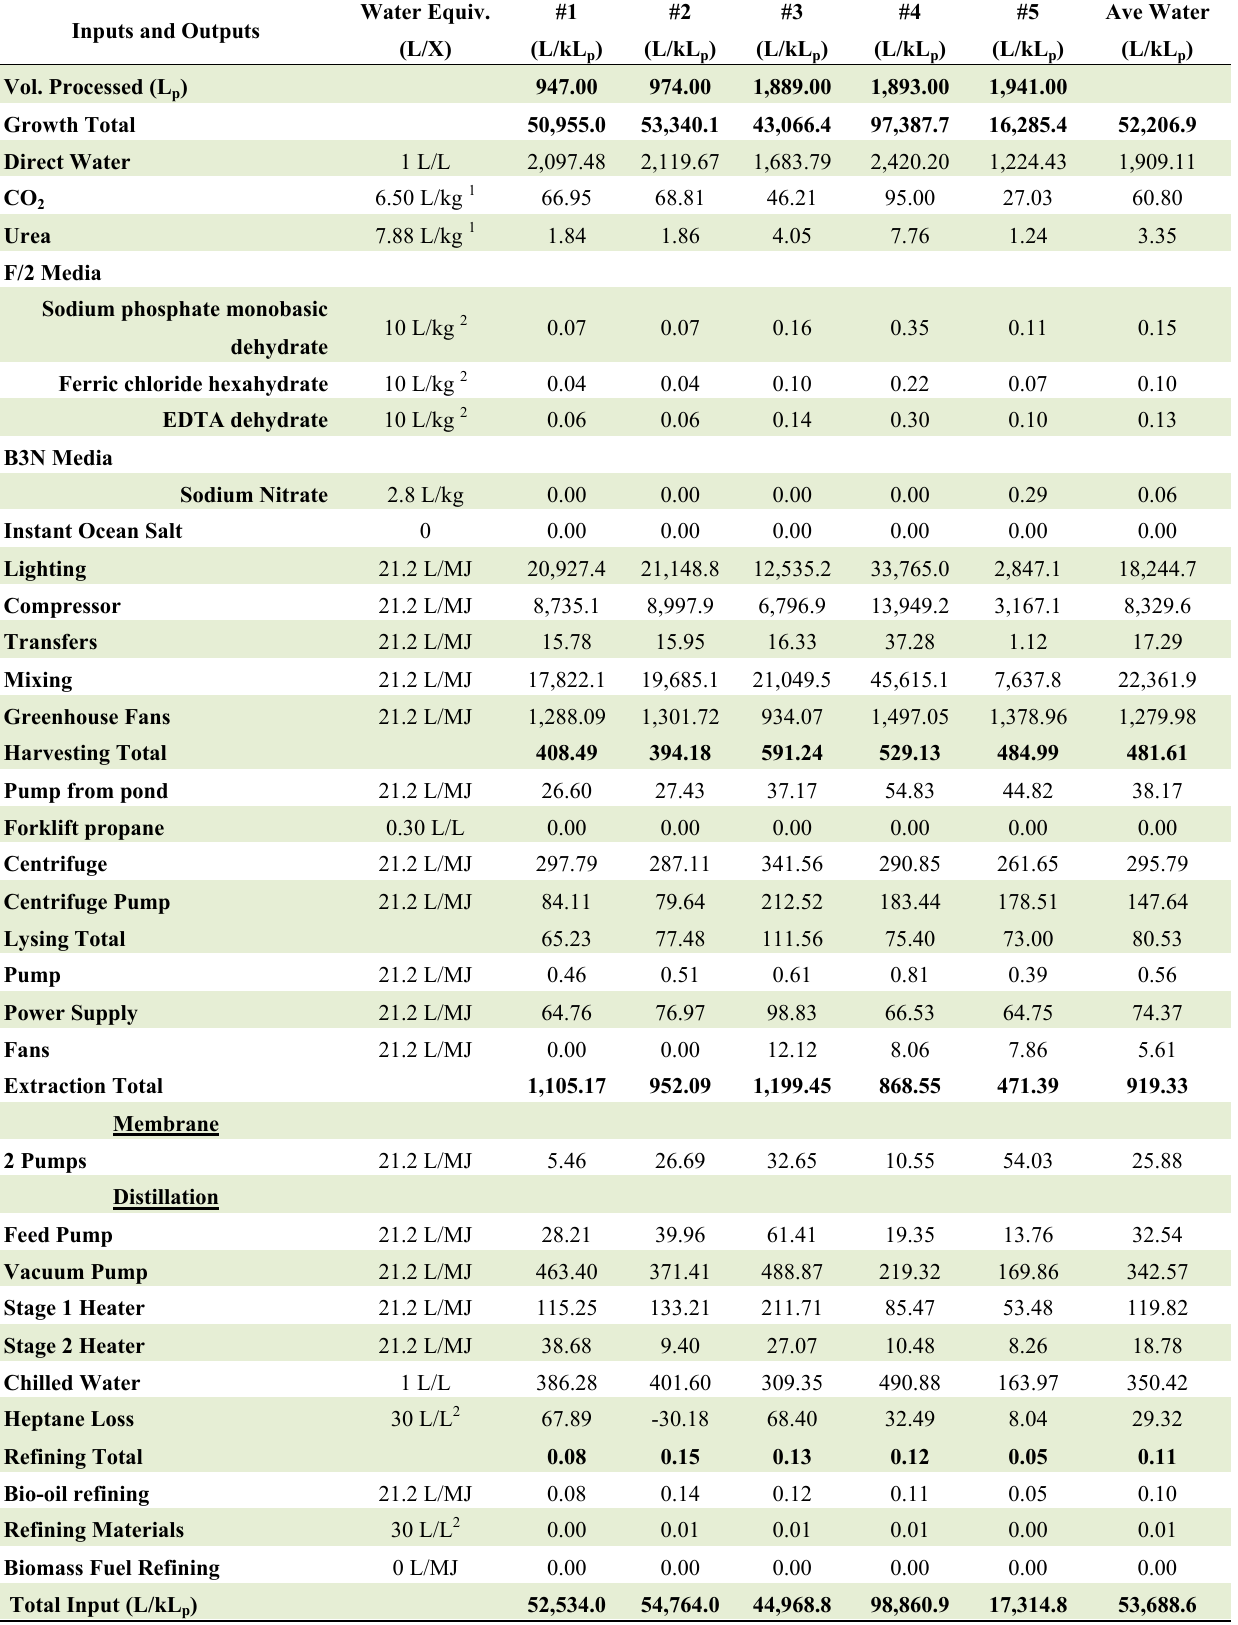
Table 4A. Water Withdrawal. Direct and indirect water withdrawal for 5 batches comprising the Experimental Case . Unless otherwise noted, data are reported in units of liters per thousand liters of processed volume (L/kL p